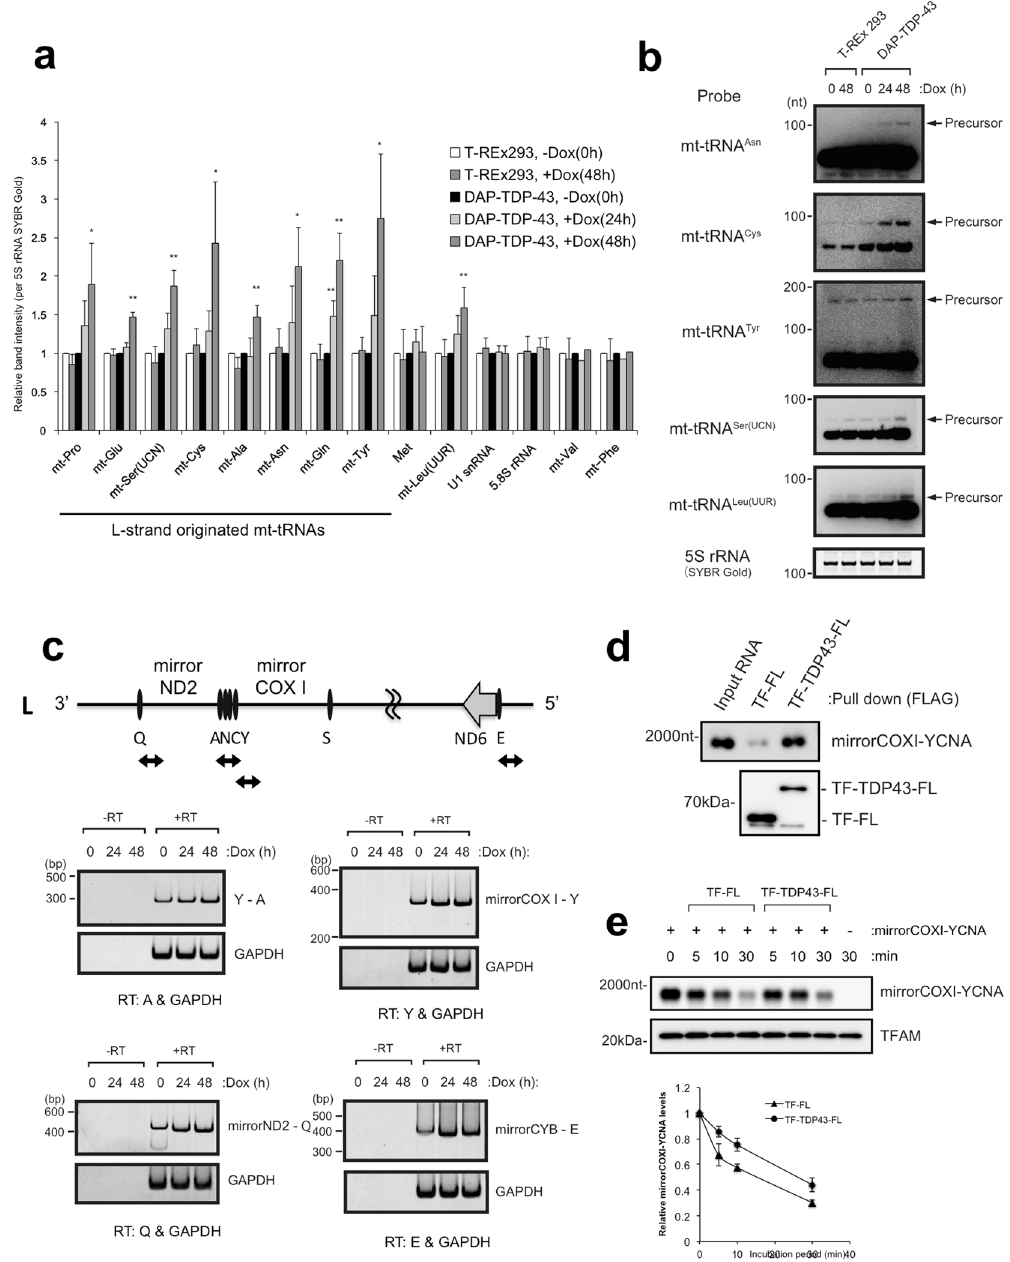
Figure 4. TDP-43 overexpression increases polycistronic transcripts of L- and H-strand mtDNA. ( a ) Relative band intensities of mt-tRNAs in total RNA extracted from DAP-TDP-43–expressing T-REx 293 cells (harvested at 0, 24, and 48 h after induction with doxycycline, Dox) were quantified by northern blotting after polyacrylamide gel electrophoresis. mt-AAA represents mt-tRNA AAA ; e.g., mt-Pro, mt-tRNA Pro , etc. 5S rRNA stained with SYBR Gold served as the loading control. Data are mean ± SD, n = 3–6. ** P < 0.01; * P < 0.05 (paired t test). ( b ) Overexposed views of representative northern blots from ( a ) showing precursor bands of each mt-tRNA. 5S rRNA stained with SYBR Gold served as the loading control. ( c ) Total RNA extracted from DAP-TDP-43– expressing T-REx 293 cells harvested at 0, 24, or 48 h after Dox induction were reverse transcribed ( + RT) or not reverse transcribed ( − RT) with the indicated gene-specific primers for L-strand-specific RT-PCR analysis. The PCR products were separated by PAGE and detected with SYBR Gold staining. The primers amplified the following: a 140-nt region in GAPDH mRNA and a 300-nt region of the L-strand transcript containing mt- tRNA Tyr , mt-tRNA Cys , mt-tRNA Asn , and mt-tRNA Ala (Y - A, top left), a 400-nt region between mirrorND2 and mt-tRNA Gln (Q) of the L-strand transcript (bottom left), a 300-nt region between mirrorCOXI and mt-tRNA Tyr (Y) of the L-strand transcript (top right), and a 400-nt region between mirrorCYB and mt-tRNA Glu (E) of the L-strand transcript (bottom right). Schematic diagrams of the corresponding PCR fragments are shown (upper diagram). ( d ) Recombinant TDP-43 fused with trigger factor (TF) and FLAG tag (FL) (TF-TDP43-FL) was mixed with synthesised mirrorCOXI-YCNA (mt-tRNA Tyr -mt-tRNA Cys -mt-tRNA Asn -mt-tRNA Ala ; 2000 nt)